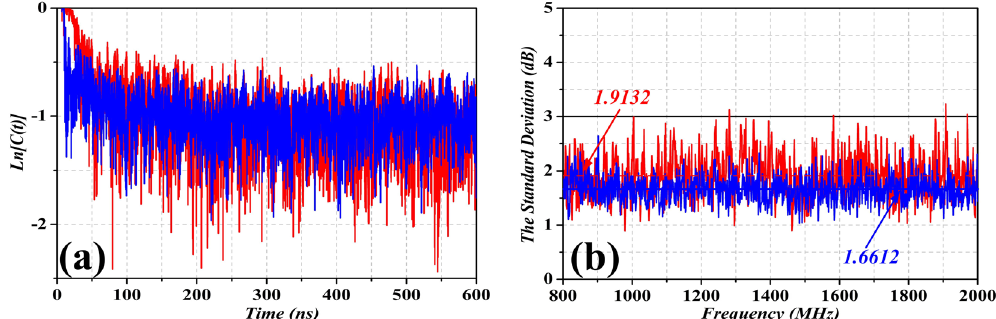
Figure 13. ( a ) Calculated Ln C t [ ( )] with 30° step degrees, for the mechanical stirrer and for the rotating metasurface, with continuous line in red and blue, respectively. ( b ) Standard deviation with respect to the mean value of maximum measures obtained by each of the 12 steps, for a complete turn of the stirrer (red line is the mechanical stirrer and blue line is the rotating metasurface).